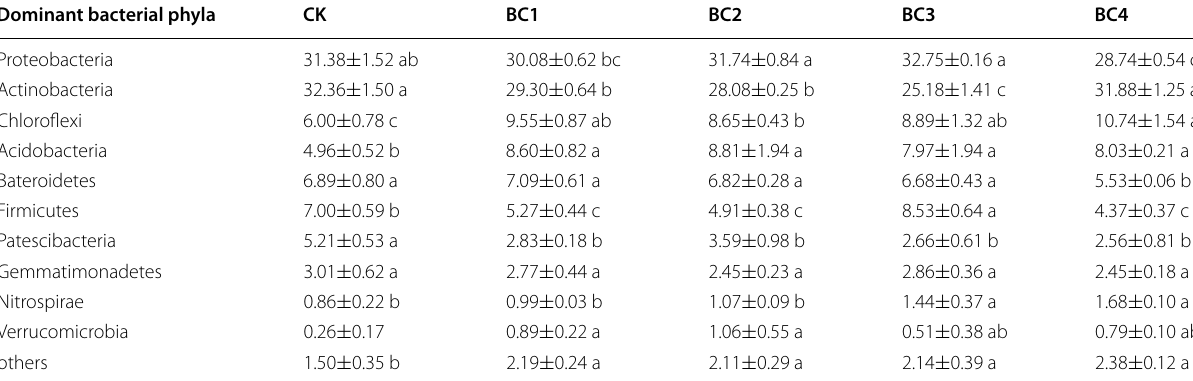
Values are mean plus standard deviation ( n 3), and data with different lowercase letters are significantly different at p < 0.05 according to Duncan’s multiple range = test. Treatments CK, BC1, BC2, BC3, and BC4 had biochar dosages of 0%, 0.5%, 1%, 2%, and 4%